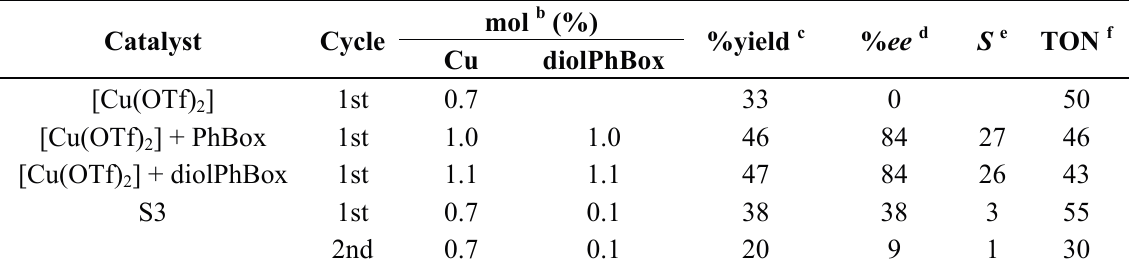
Table 4. Kinetic resolution of 1,2-diphenylethane-1,2-diol by the S3 material and CuPhBox, CudiolPhBox in homogeneous phase (Scheme 1).